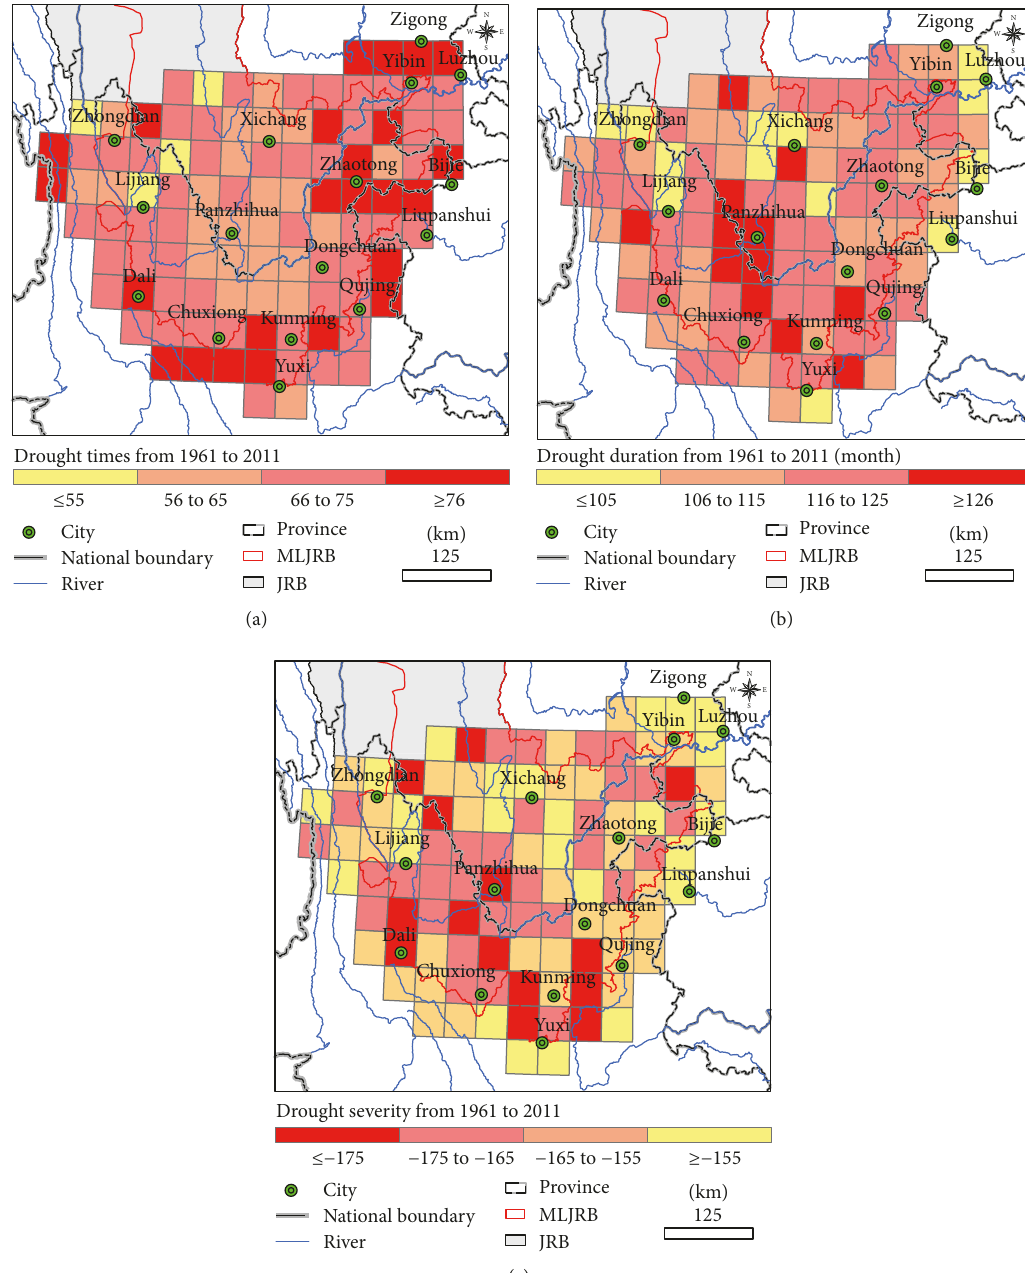
Figure 13: Spatial distribution of the DT (a), DD (b), and DS (c) in the MLJRB during 1961 to